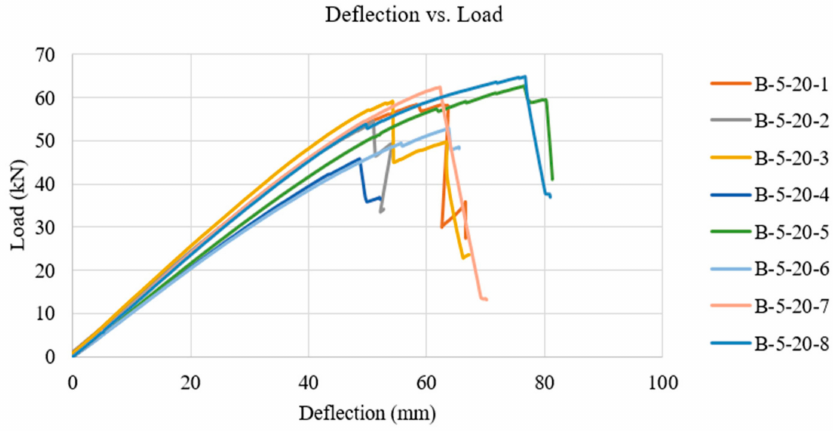
Figure 4. Panel configuration B-5-20: deflection to failure load